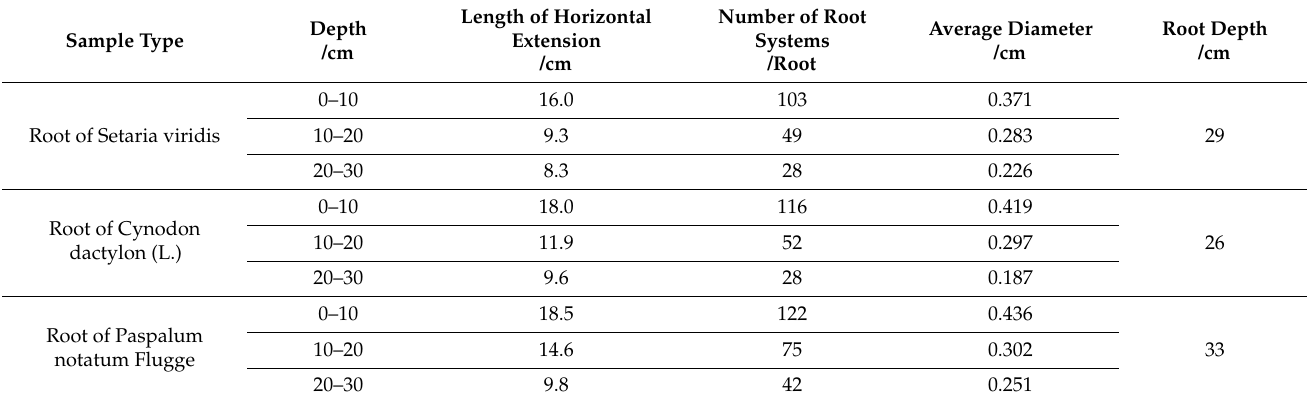
Table 2. Basic physical properties of vegetation root systems.